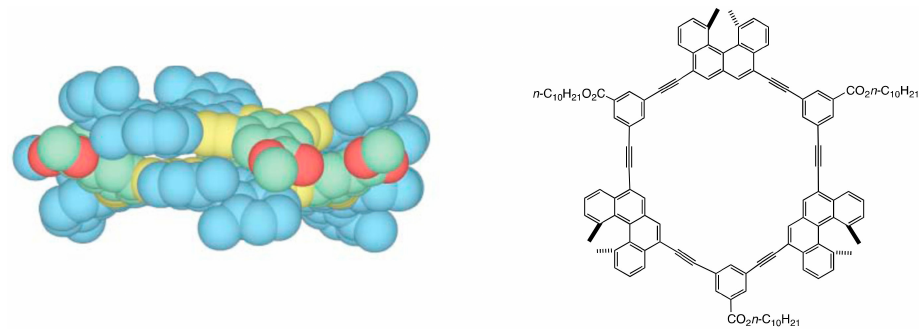
Figure 10. Calculated structure of dimeric ( P )-[3 + 3]cycloalkyne. Reproduced from reference 52 by permission from ACS, Washington, DC,